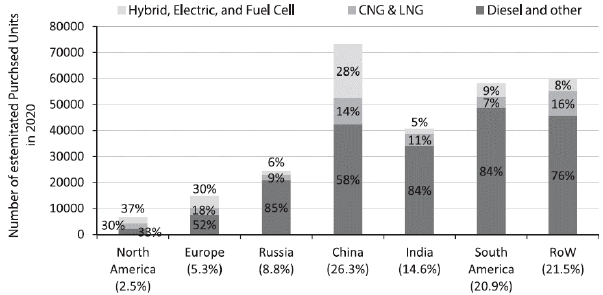
Fig. 2. Distribution of estimated bus market share in 2020 [10].